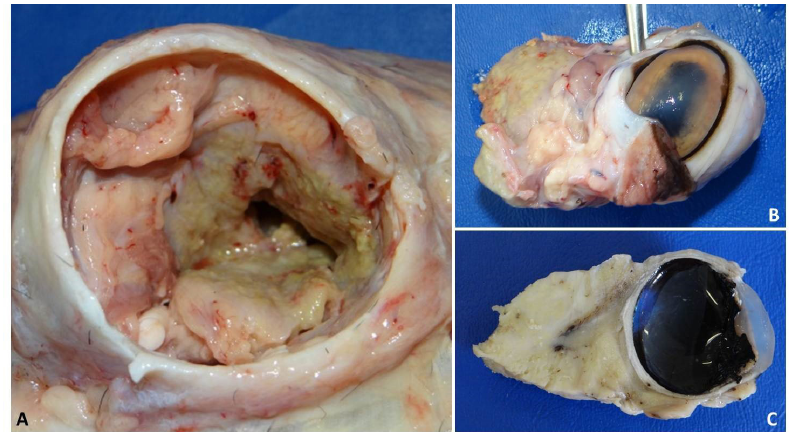
figura 4. Condiobolomicose em ovinos. Ovino 2PS. (A) Órbita direita. Notar massa amarelada invadindo a cavidade orbital, após a remoção do olho e parte da massa retro bulbar (mostrada em B); (B) Grande massa amarelada aderida ao globo ocular; (C) Superfície de corte da Figura (B) evidenciando a aderência de massa ao globo ocular.